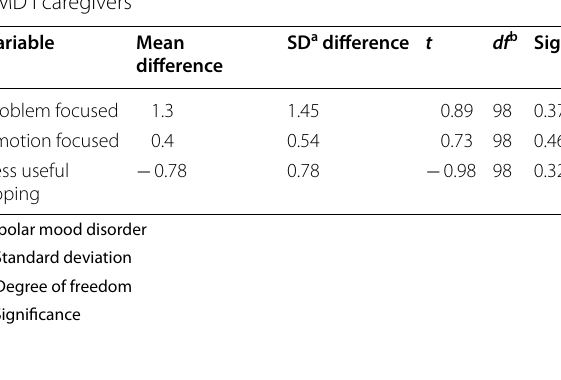
Table 2 Comparison of coping strategies in schizophrenia